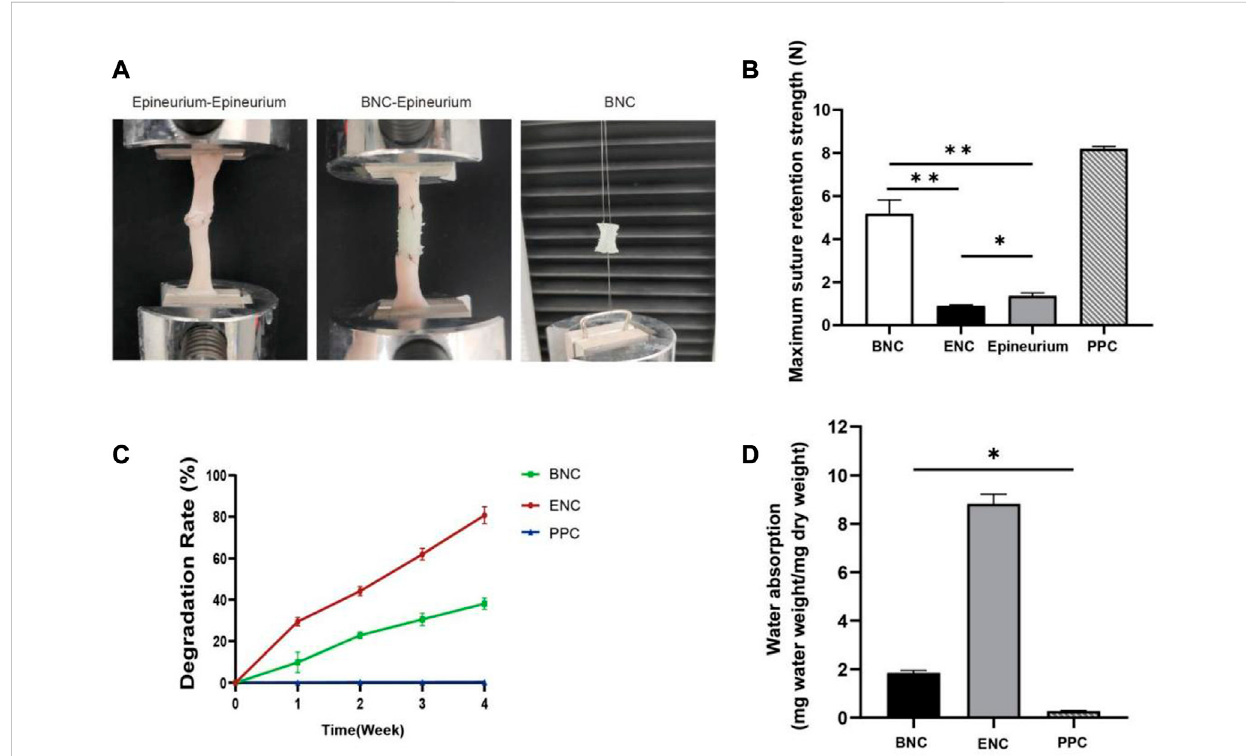
FIGURE 4 Assessment of the max suture retention strength. (A) Schematic representation of suture retention strength tested in vitro . (B) Suture retention strength was assessed to analyze mechanical properties of BNC, ENC, and PPC. (C) Weight change of BNC, ENC, and PPC during in vitro degradation in PBS at 37 ° C. (D) Water absorption analysis was performed to evaluate the effect of microstructure on the internal liquid exchange in BNC, ENC, and PPC. Data are expressed as the mean ± SD ( n = 5) (* p < 0.05, ** p <